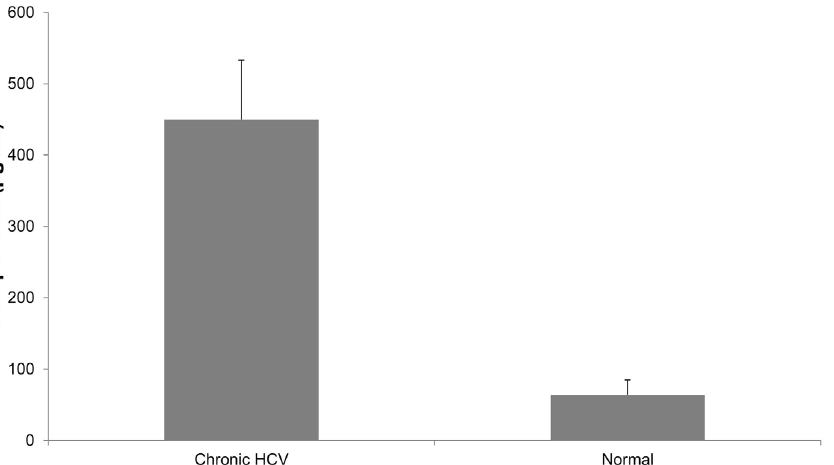
Figure 3. Increased TGF- b in serum of HCV patients. We measured the levels of TGF- b in the sera of chronic HCV patients and compared them to normal subjects using a TGF- b ELISA kit. The bars represent the mean 6 SD levels of TGF- b concentration. The levels of TGF- b in the sera from chronic HCV patients were significantly elevated when compared to healthy controls (450 vs. 64 m g/ml, p , 0.05).